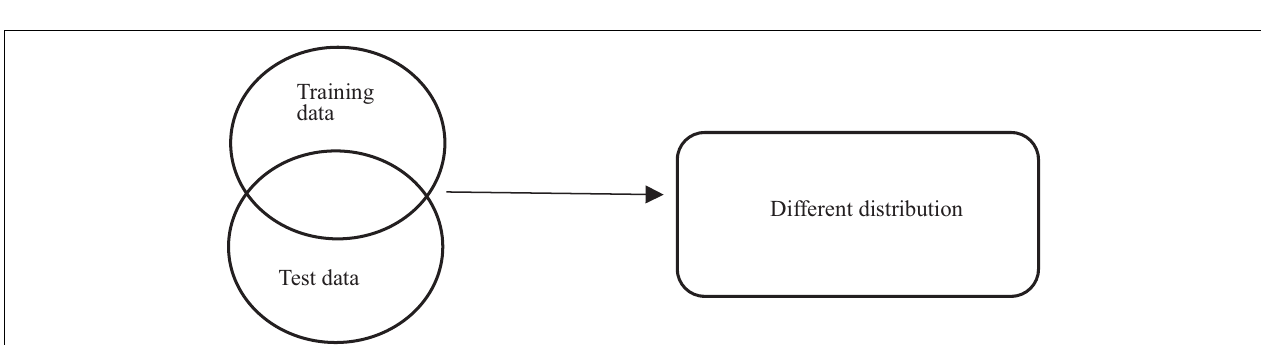
FIGURE 2 | Actual data distribution scenario.